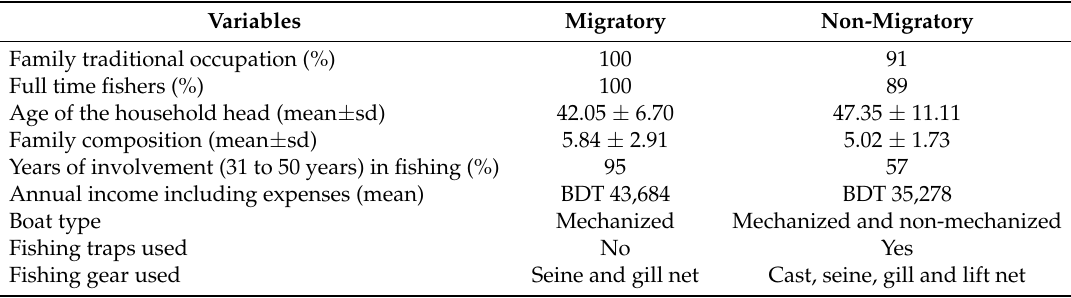
Comparative characteristics of migratory and non-migratory fishers of the Padma River, Bangladesh. Variables Migratory